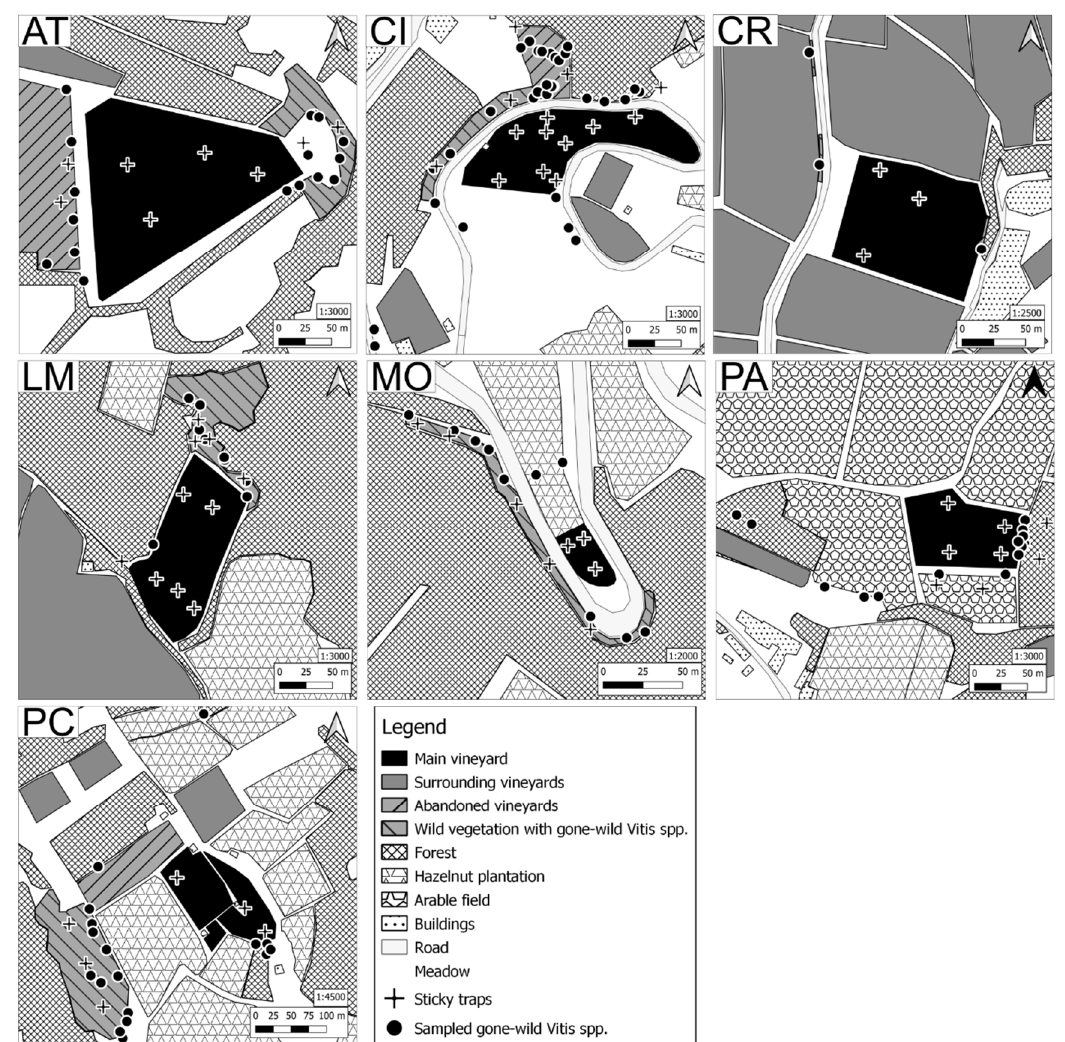
Figure 2. Stylized vegetal composition of the seven vineyards and surroundings. Acronyms: AT, Asti; CI, Cisterna d’Asti; CR, Castel Rocchero; LM, La Morra; MO, Montà d’Alba; PA, Paderna; PC, Portacomaro.